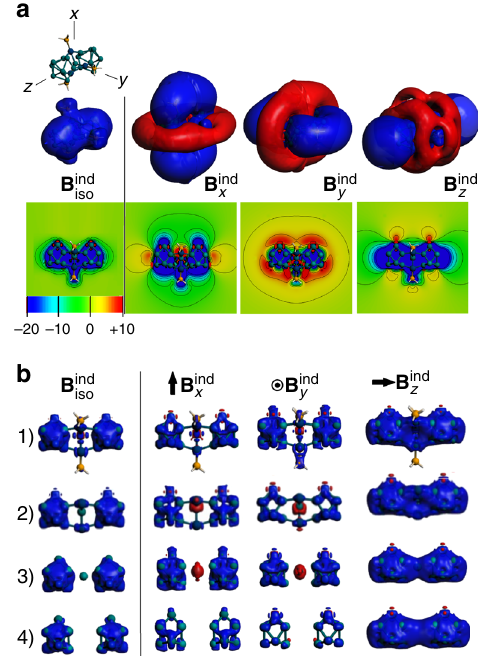
Fig. 6 Plots and isosurfaces of magnetic response of the studied cluster. a Induced magnetic fi eld of the studied cluster involving an orientation averaged (B ind iso ) and orientations of the external fi eld along three representative axes. Isovalue set to ±2 ppm (top). The cut-plane representations are given (bottom). Blue: shielding; Red: Deshielding surfaces. b Shielding surfaces (35 ppm) for {(Ge 9 ) 2 [ η 6 -Ge(PdPH 3 ) 3 ]} 4 − (1), the unligated core {(Ge 9 ) 2 [ η 6 -GePd 3 ]} 4 − (2), the core without Pd-atoms {(Ge 9 ) 2 [ η 6 -Ge]} 4 − (3), and the non-bridged species [Ge 9 Ge 9 ] 4 −